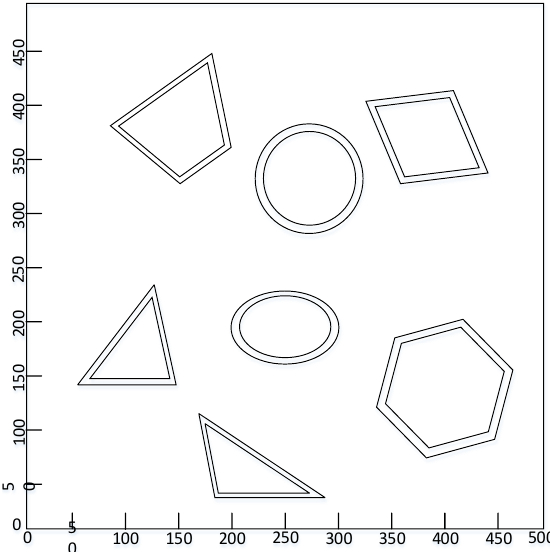
Figure 9. Map processed with the swelling treatment.